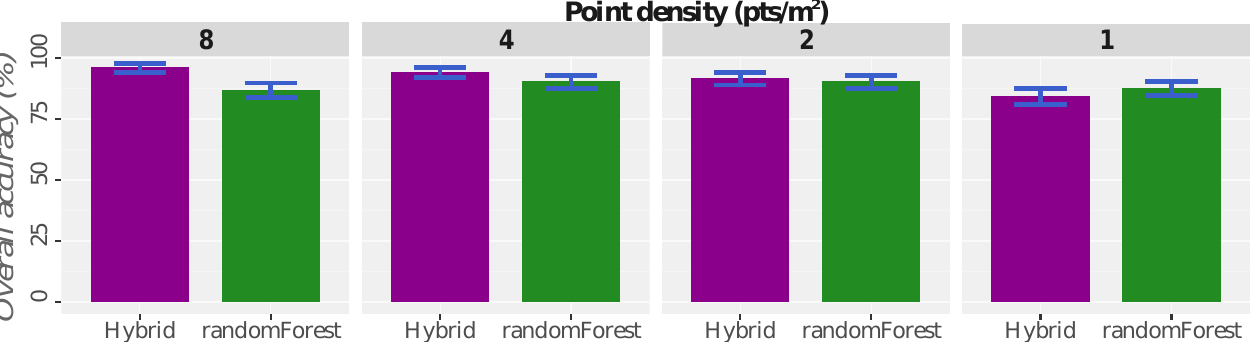
Figure 9. Hybrid vs. RF: Overall accuracy (%) for point clouds with densities of 8 (first column), 4 (second column), 2 (third column) and 1 (last column) point/m 2 .